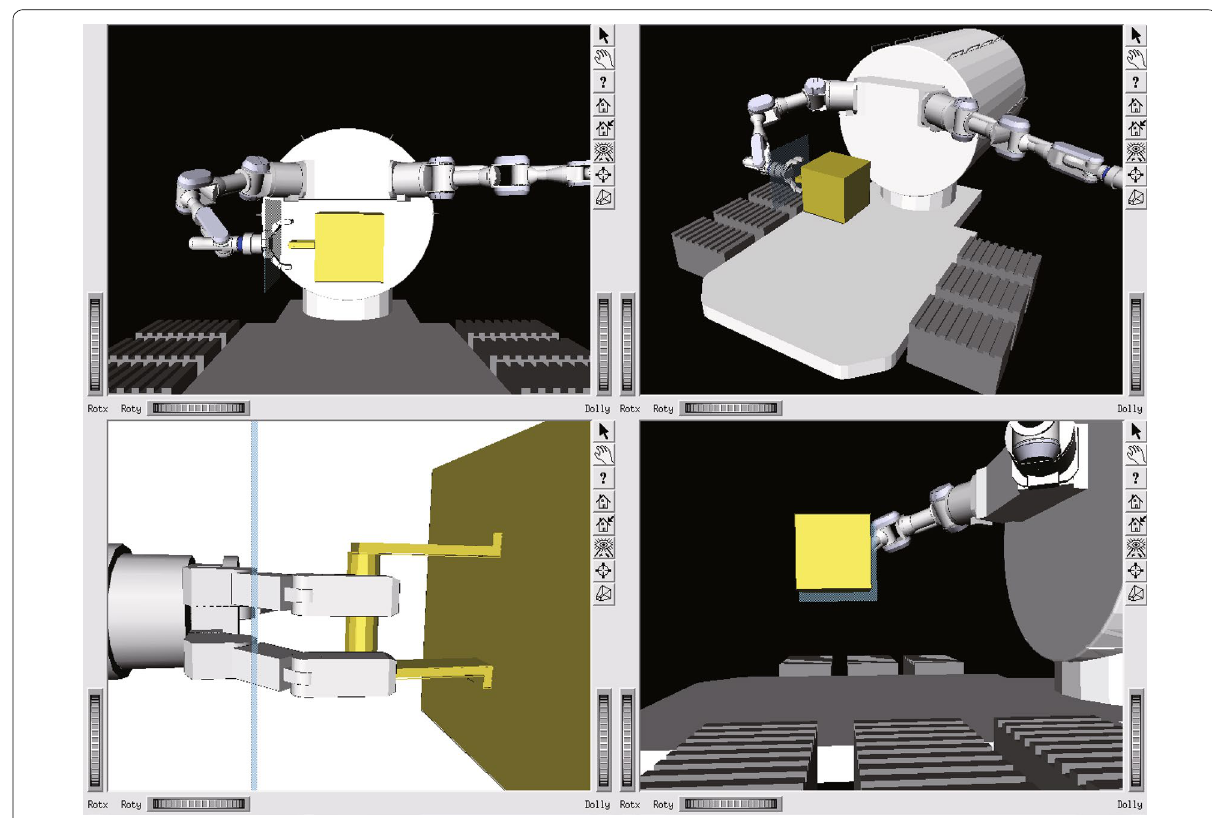
Fig. 7 Overview of virtual environment